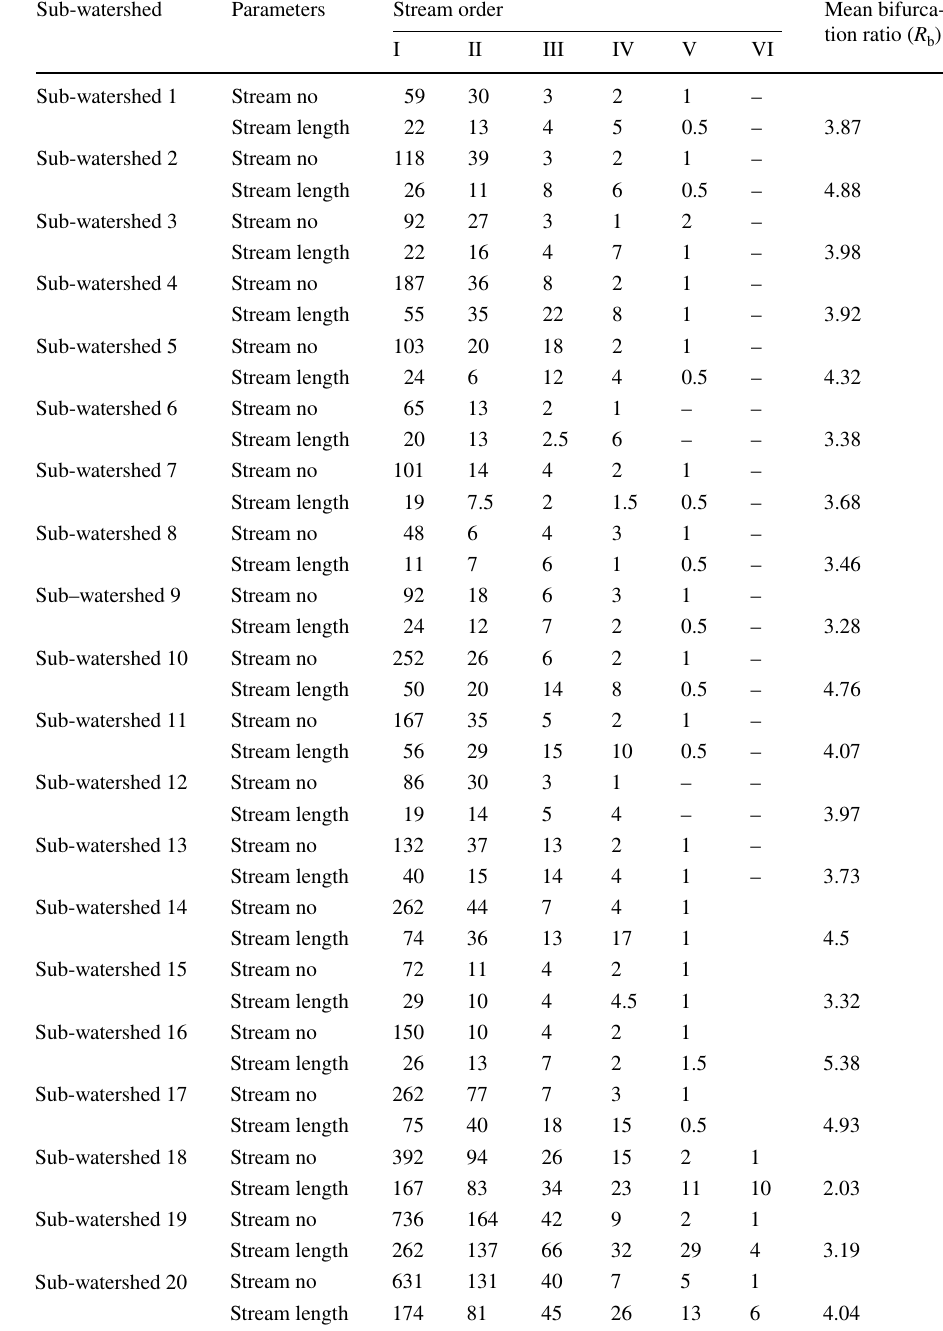
Table 4 Linear aspects of